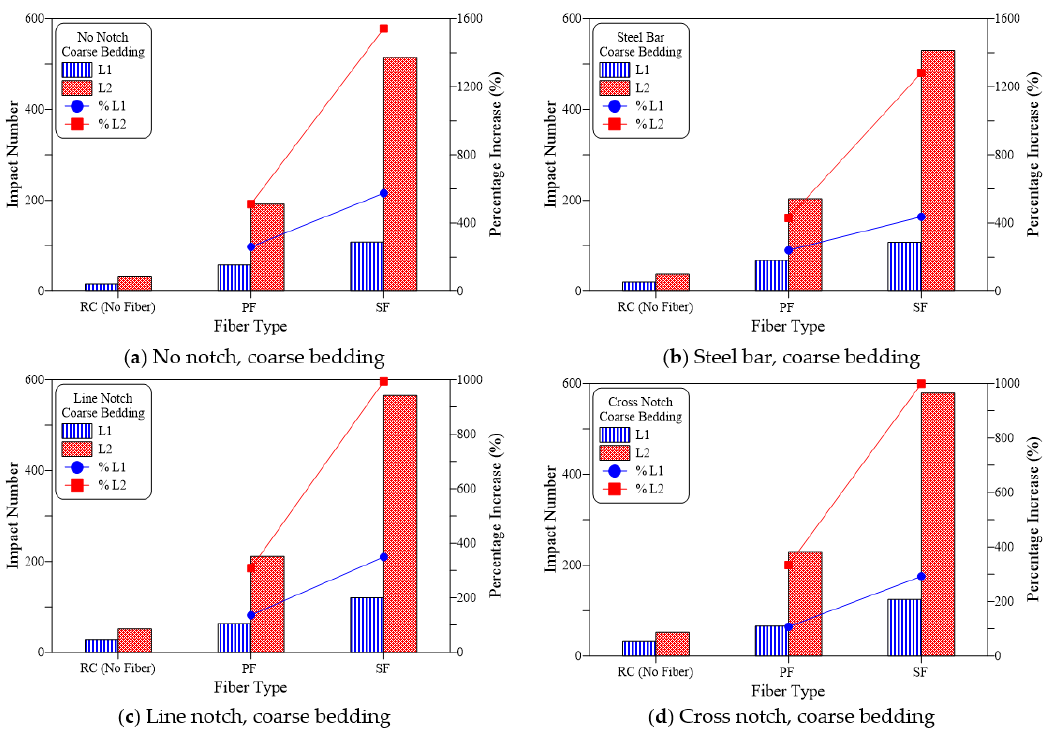
Figure 11. Fiber type effect on cracking and failure impact numbers of coarse bedding specimens. ( a ) No notch, coarse bedding, ( b ) Steel bar, coarse bedding, ( c ) Line notch, coarse bedding, ( d ) Cross notch, coarse